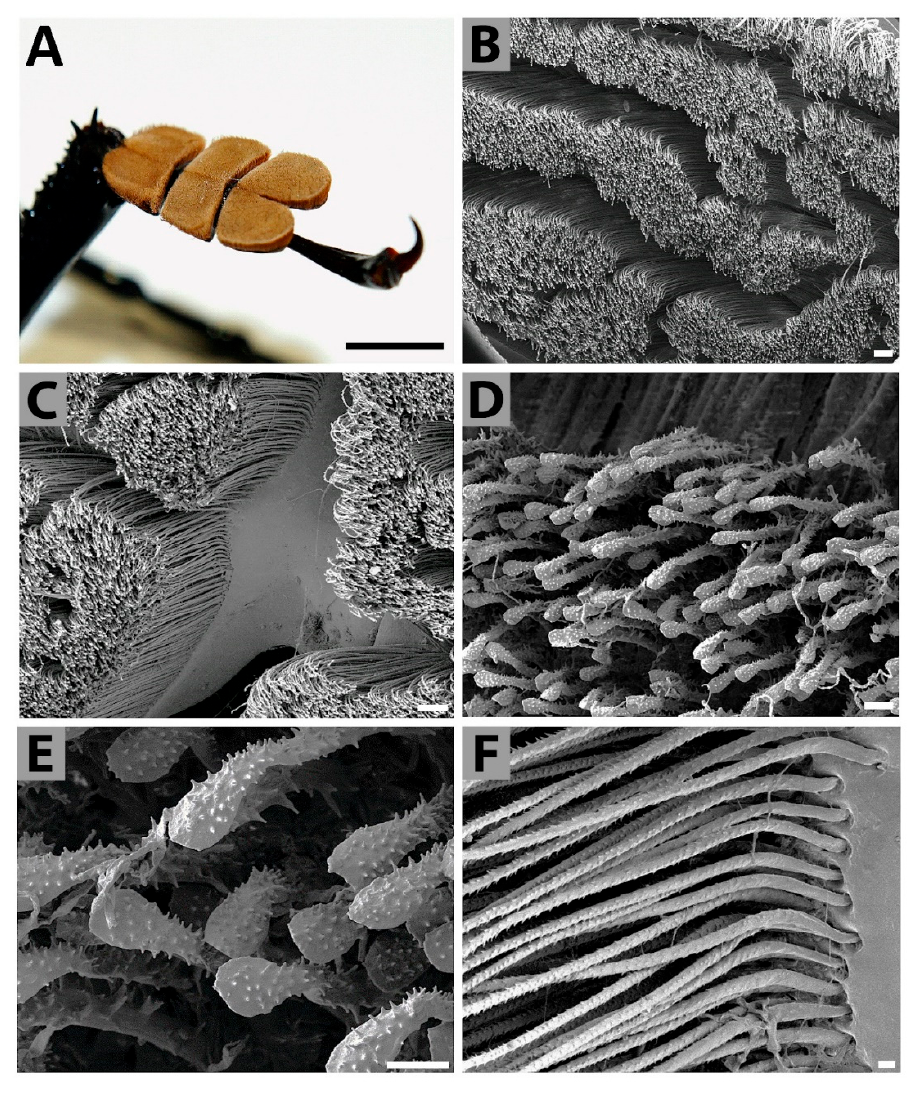
Figure 3. Macrophoto ( A ) and scanning electron microphotographs ( B – F ) of T. giganteus tarsus. ( B )—General view on the tarsal hairs grouped in wide and irregular rows. ( C )—Detail of the tarsal hairs field. ( D )—Semi-detail of individual adhesive tarsal hairs. ( E )—Full detail of the adhesive tarsal spatulate hairs. ( F )—Attachment of the adhesive tarsal hairs to the tarsal base (cuticle). Scale bar: 5 mm ( A ); 100 μ m ( B , C ); 10 μ m ( D – F ).